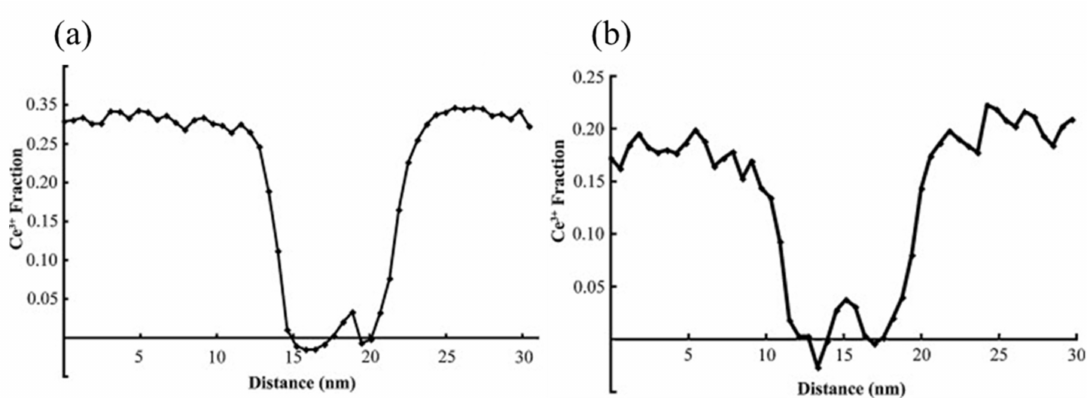
Figure 23. Plots of the Ce 3+ fraction from STEM-EELS line profiles across grain boundaries in cerium oxide doped with Gd and Fe with around ( a ) 30% and ( b ) 20% Ce 3+ in the bulk [196]. Figure 23 reprinted from Journal of the European Ceramic Society, 34, J.P. Winterstein and C.B. Carter, Electron-beam damage and point defects near grain boundaries in cerium oxide, 3007–3018, Copyright (2014), with permission from